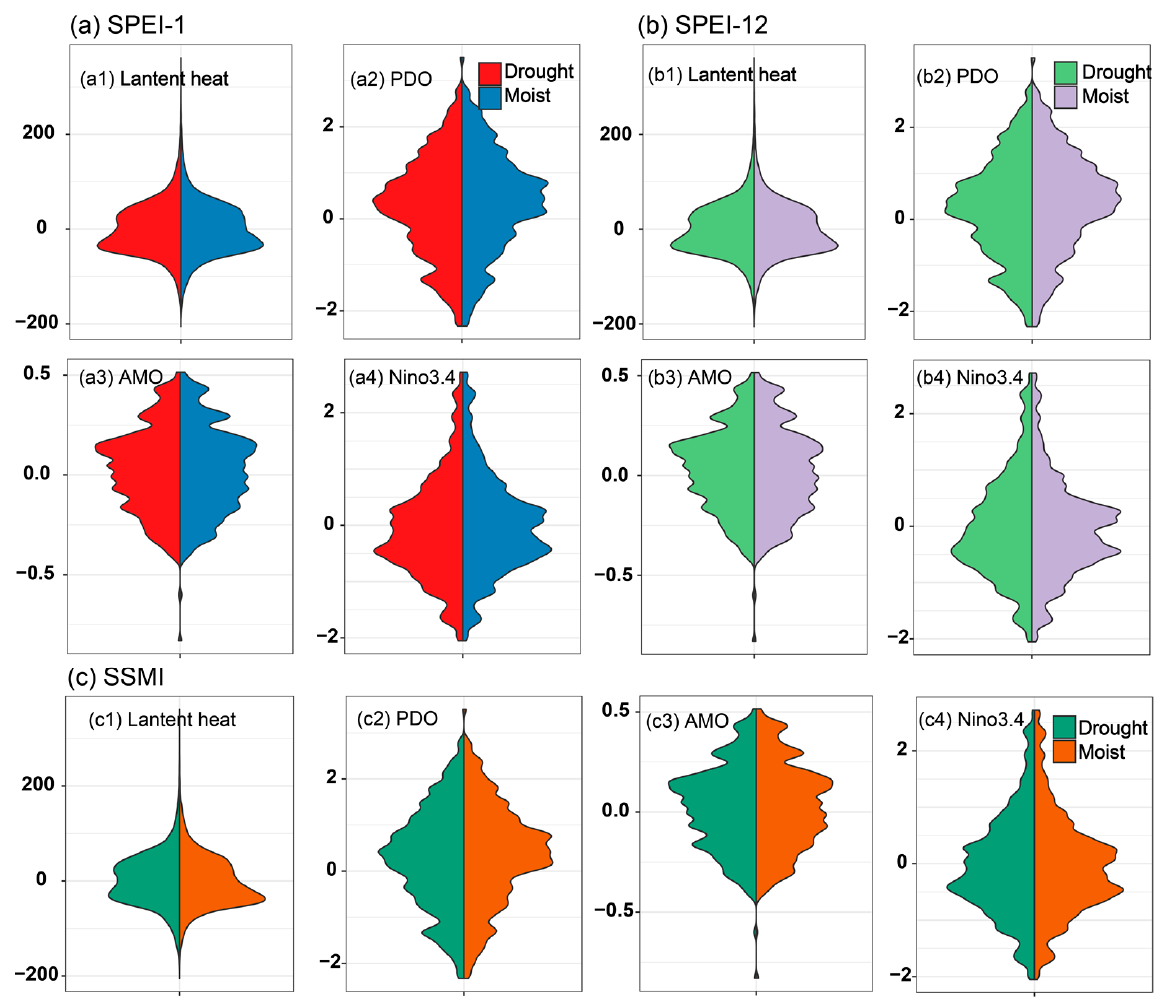
Figure 3. Response of LHF, PDO, AMO, and Nino3.4 to dry and non-drought months indices in China. The PDO distributions of all drought indices were essentially similar in drought and non-drought months (Figure 3a2,b2,c2) (mean difference < 0.2). The PDO values in drought months tended to be negative, indicating that the probability of drought in China increases when the PDO is negative. AMO values were higher in drought months than in non-drought months, but the difference in SPEI-1 (mean value less than 0.1) (Figure a3) was less pronounced than in SPEI-12 (Figure b3) or soil drought (Figure c3). Short-term meteorological droughts have less of an impact on the entire Chinese region than other drought types. The data distribution of the Nino3.4 index showed the largest difference between dry months and non-drought months among the analyzed indices. The average Nino3.4 index values in dry months were mainly concentrated at approximately − 0.5, while in non-drought months, two peaks at − 0.5 and 0.5 were observed. This finding shows that when the Nino3.4 index is negative, the drought conditions in mainland China are closely related to the occurrence of a La Niña